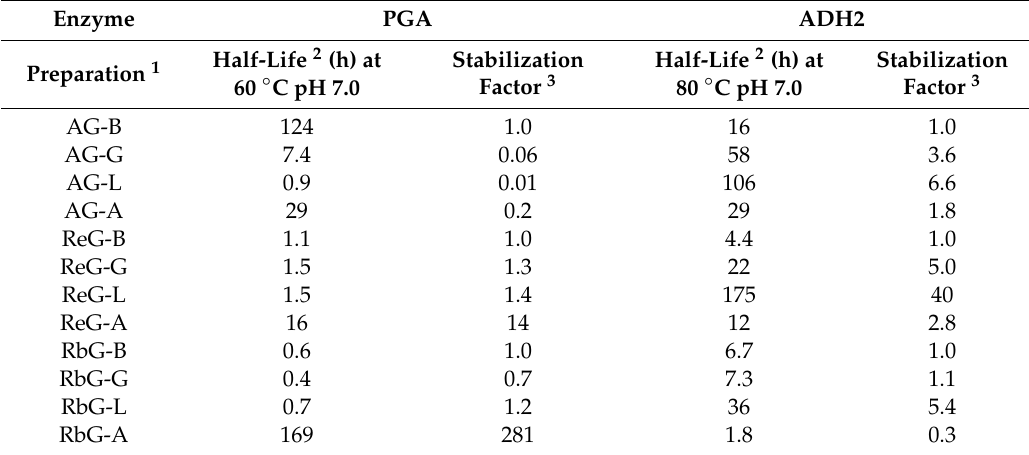
Table 4. Stabilization parameters of the PGA and ADH2